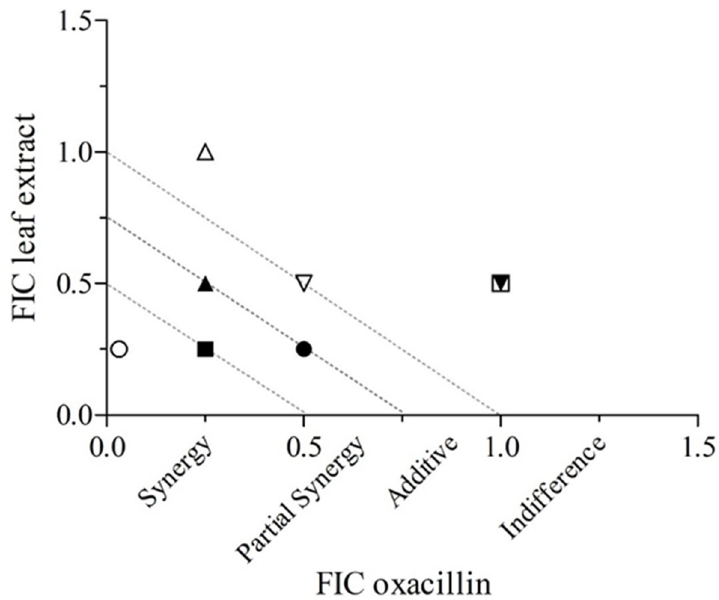
Figure 1. Isobolograms showing the synergy (FIC index ≤ 0.5), partial synergy (0.5 ≤ FICI ≤ 0.75), additive (0.76 ≤ FICI ≤ 1), and indifference (1 < FICI ≤ 4) effects of oxacillin and S. torvum leaf extract: